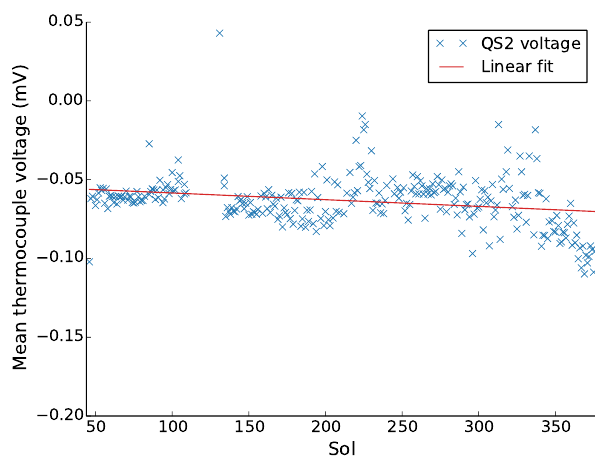
Figure 12. Bias correction of QS2.